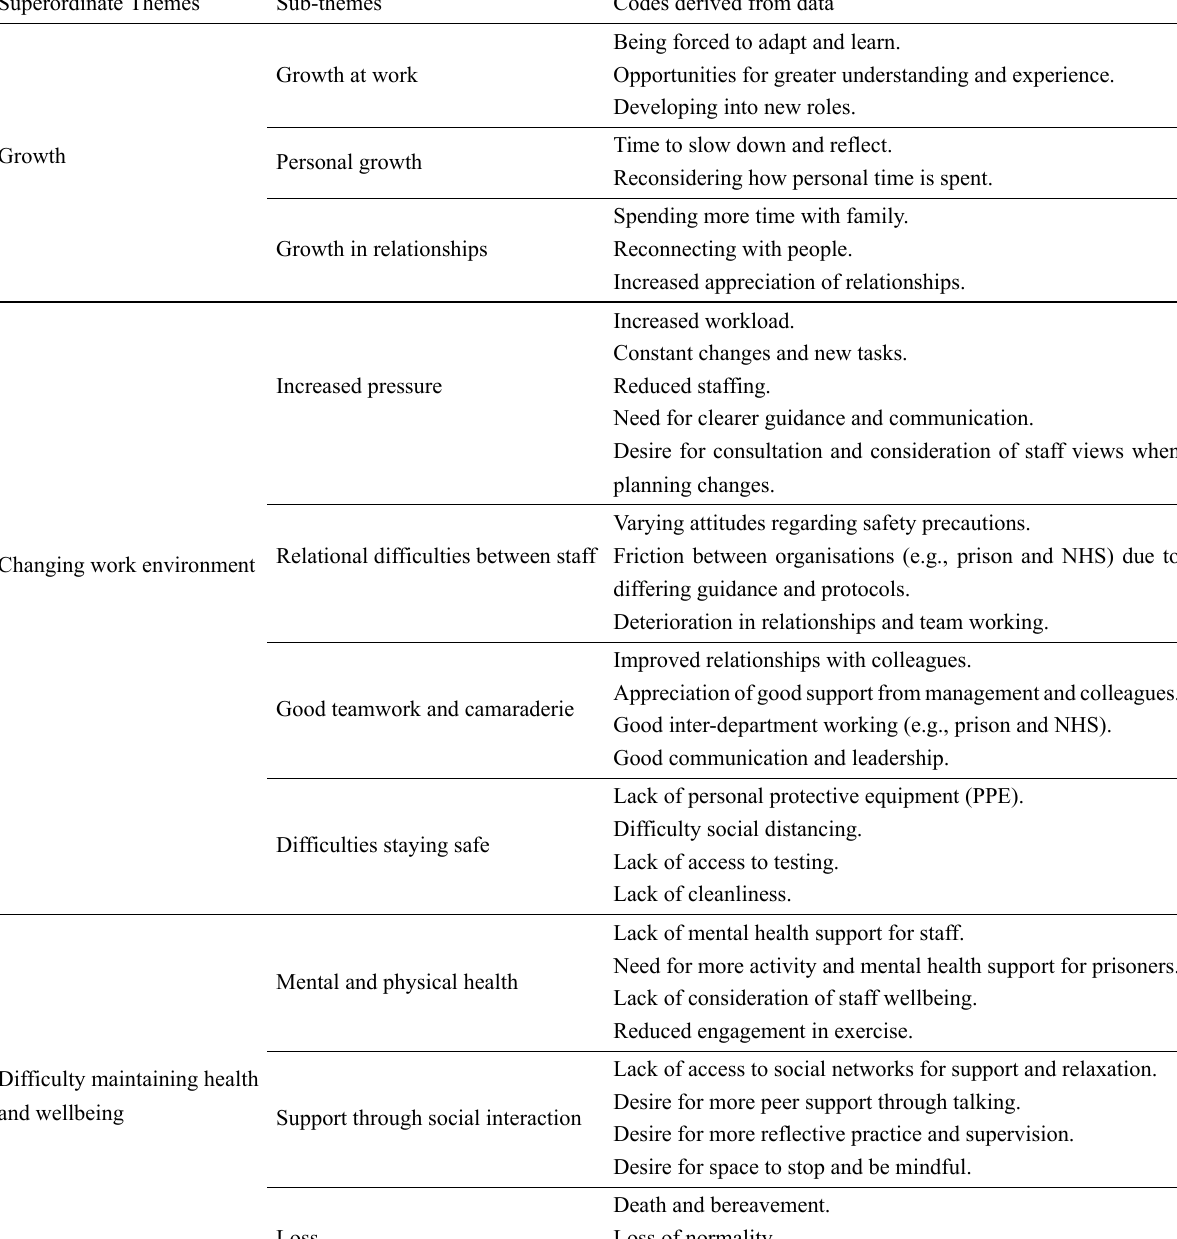
Table 11. Superordinate themes, sub-themes, and codes derived from staff